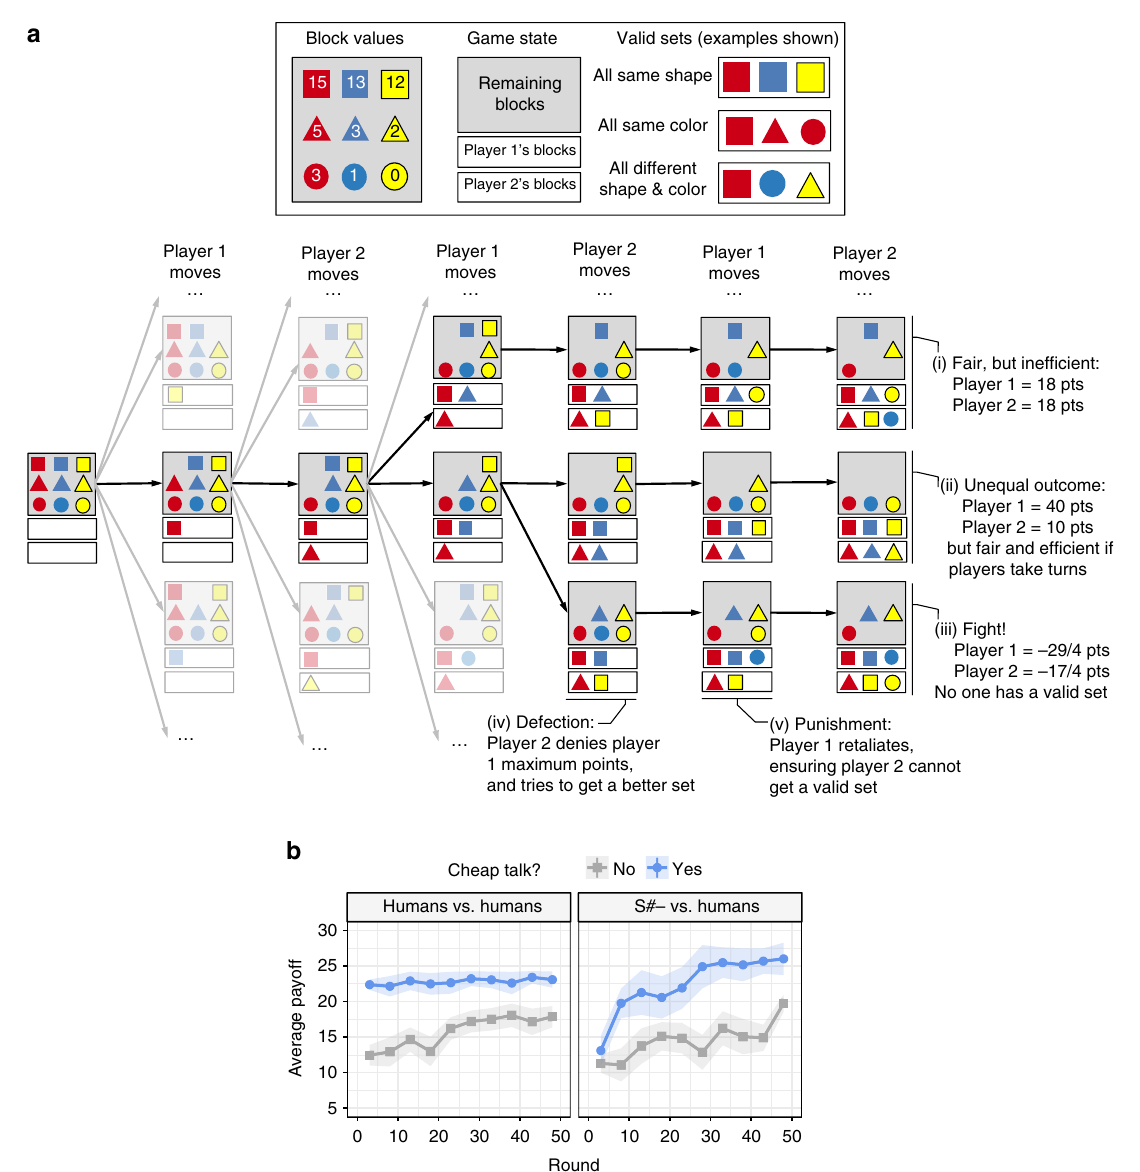
Fig. 6 Results in a repeated stochastic game called the Block Game. a A partial view of a single round of the Block Game in which two players share a nine- piece block set. The two players take turns selecting blocks from the set until each has three blocks. The goal of each player is to get a valid set of blocks with the highest point value possible, where the value of a set is determined by the sum of the numbers on the blocks. Invalid sets receive negative points. The fi gure depicts fi ve different potential outcomes for each round of the game, ranging from dysfunctional payoffs to outcomes in which one or both players bene fi t. The mutually cooperative (Nash bargaining) solution occurs when players take turns getting the highest quality set of three blocks (all the squares). b Average payoffs obtained by people and S# – (an early version of S# that generates, but does not respond to, cheap talk) when associating with people in the Block Game. Error ribbons show the standard error of the mean. As in normal-form games, S# – successfully uses cheap talk to consistently forge cooperative relationships with people in this repeated stochastic game. For more details, see Supplementary Note